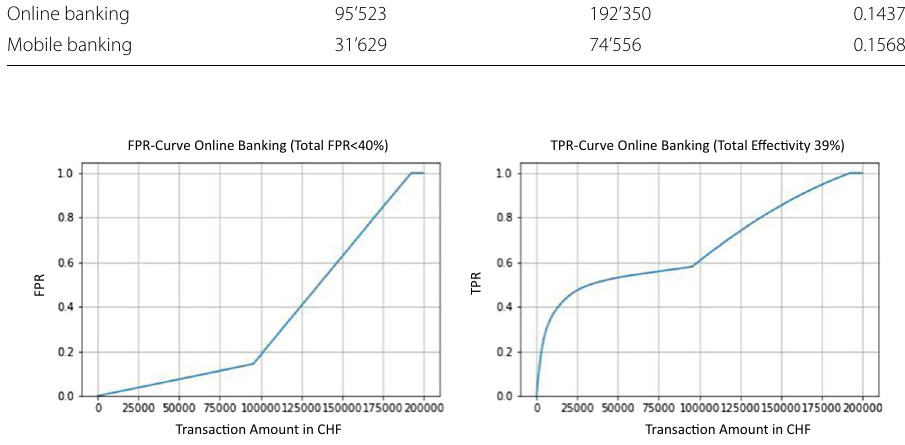
Fig. 1 Panel Left: False positive rate as a function of the transaction amount under the constraint that the total false positive rate is smaller than 0.4 percent. Right Panel: True positive rate as a function of the transaction amount. The total effectiveness is 39